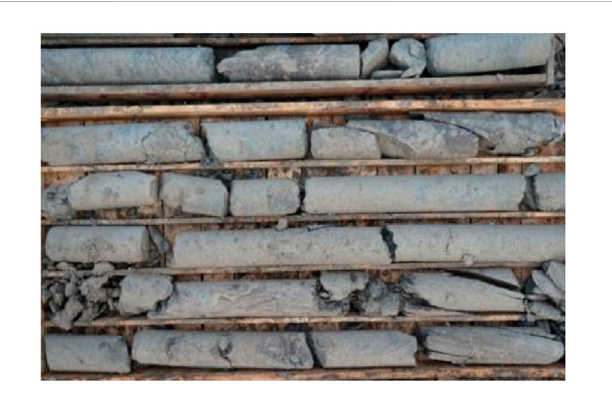
FIGURE 2 Drilling core of the mud-shale at a depth of 80 – 90